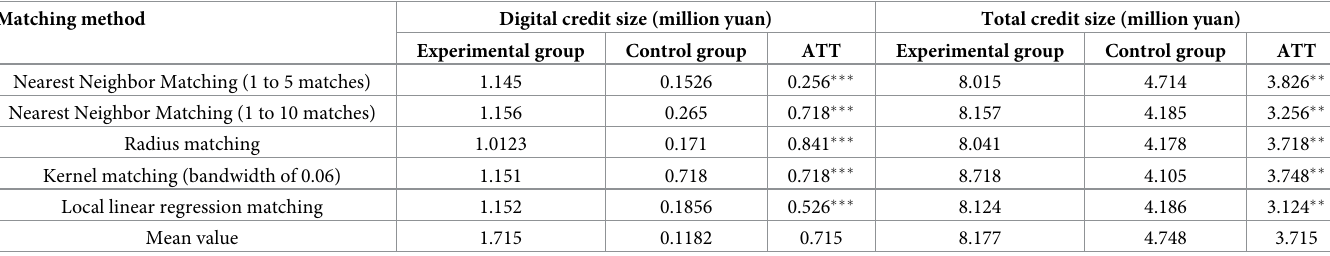
Table 8. Estimated results of the impact of participation in e-commerce on the credit size of farm households. Matching